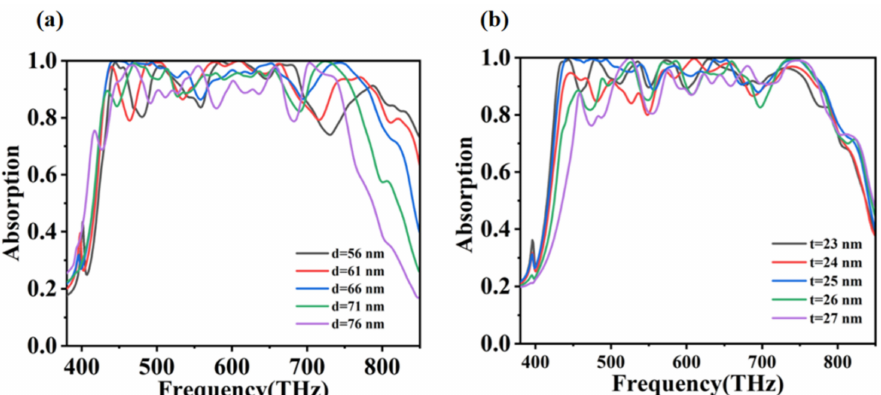
Figure 9. ( a ) Absorption spectrum when varying the thickness of the ZnS dielectric layer d (56–76 nm) at 380–830 THz. ( b ) Absorption spectrum when varying the thickness of the absorbed Au layer t (23–27 nm) at 380–830